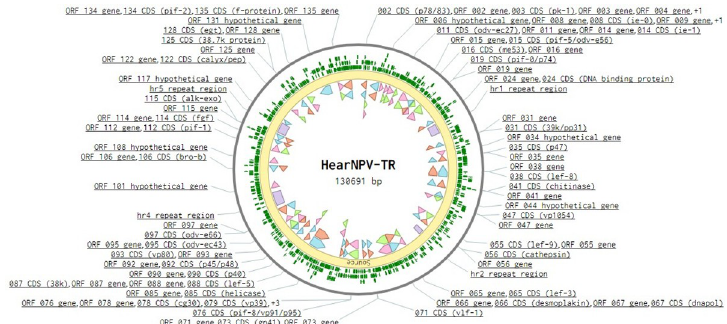
Fig 1. Circular genome map of sequenced HearNPV-TR